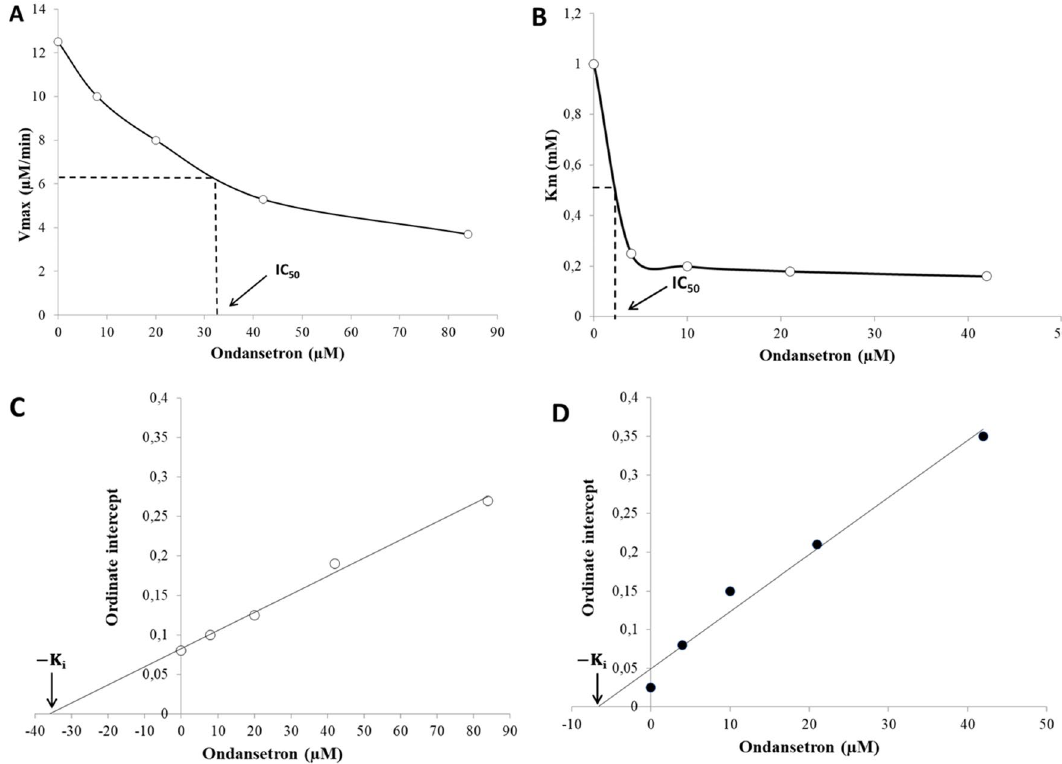
Figure 7. IC 50 values for Ondansetron in ( A ) AChE, and ( B ) BChE. The secondary plot shows the K i values in ( C ) AChE, and ( D ) BChE.